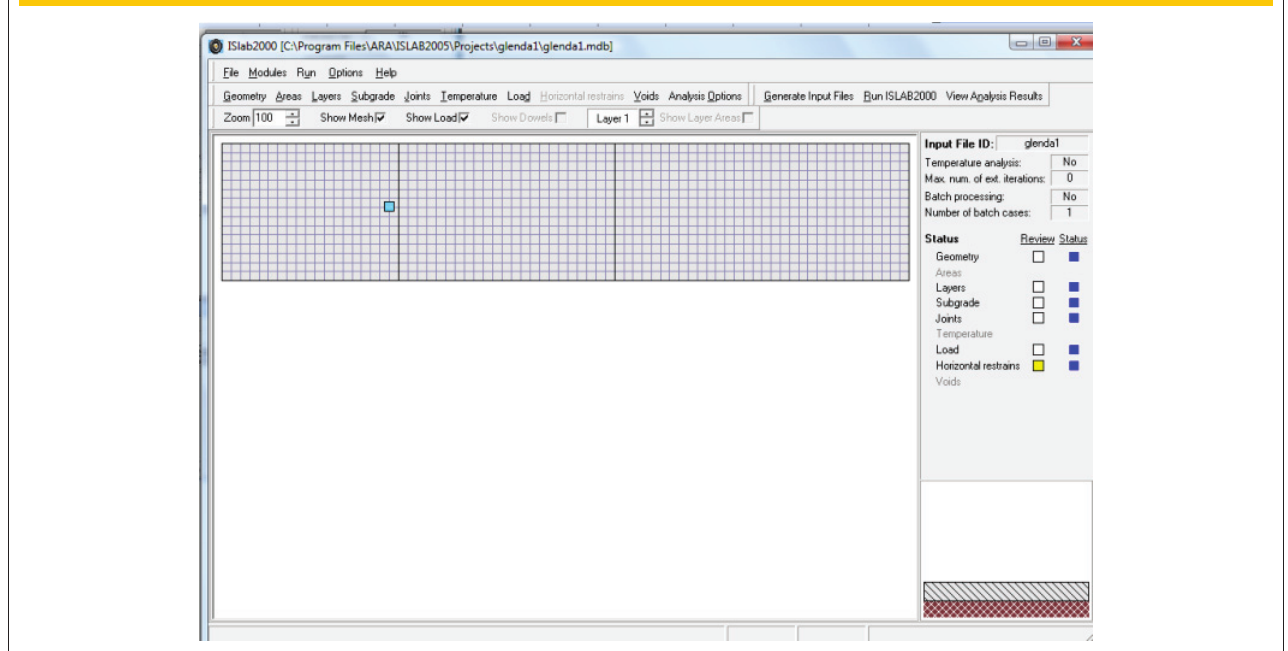
Figure 3 – Finite element mesh for simulation of FWD load test at non-doweled joint using